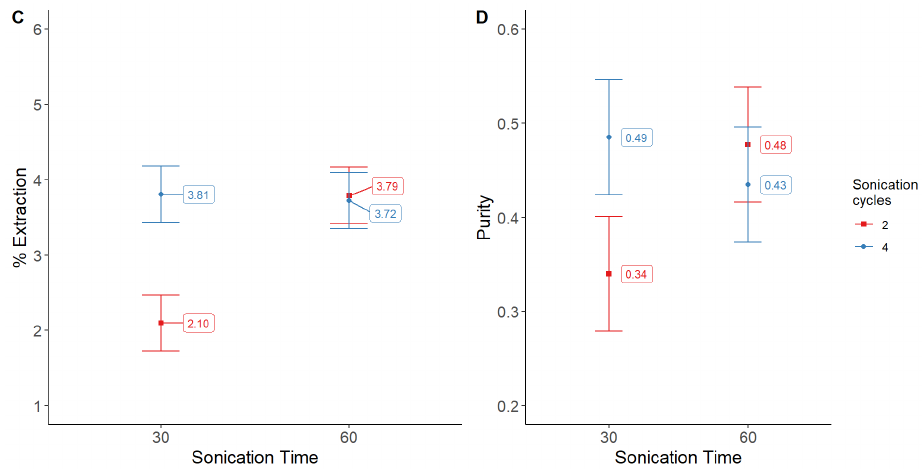
Figure 5. Interaction plots for yields of phycocyanin (%) ( A ) Sonication cycles vs. pH; ( B ) Sonication time vs. pH; ( C ) Sonication time vs. Sonication cycles. Interaction plot for purity of the extracted phycocyanin, ( D ) Sonication time vs. Sonication cycles. Bars show the means and least significant difference intervals for 95% confidence.